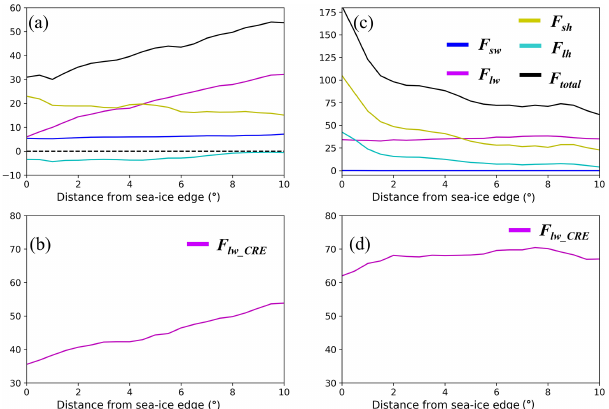
Figure 10. The average meridional evolution in the anomalies of (a) the sum ( F total , Wm − 2 ; black) and individual surface fluxes of sensible heat ( F sh , Wm − 2 ; yellow), latent heat ( F lh , Wm − 2 ; cyan), net longwave irradiance ( F lw , Wm − 2 ; magenta), and net shortwave irradiance ( F sw , Wm − 2 ; blue) along the trajectories. Panel (b) shows the cloud radiative effect by longwave irradiance ( F lw_CRE ; magenta) over the Barents Sea. Panels (c) and (d) are the counterparts of panels (a) and (b) over the frozen